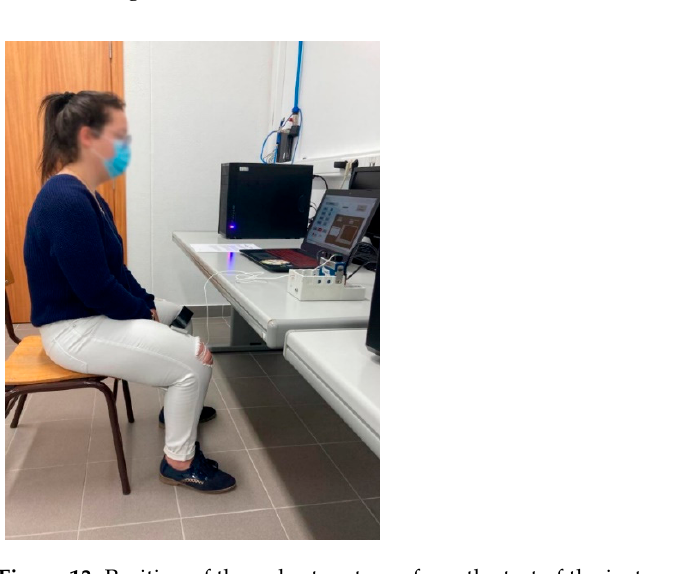
Figure 13. Position of the volunteer to perform the test of the instrumented device.